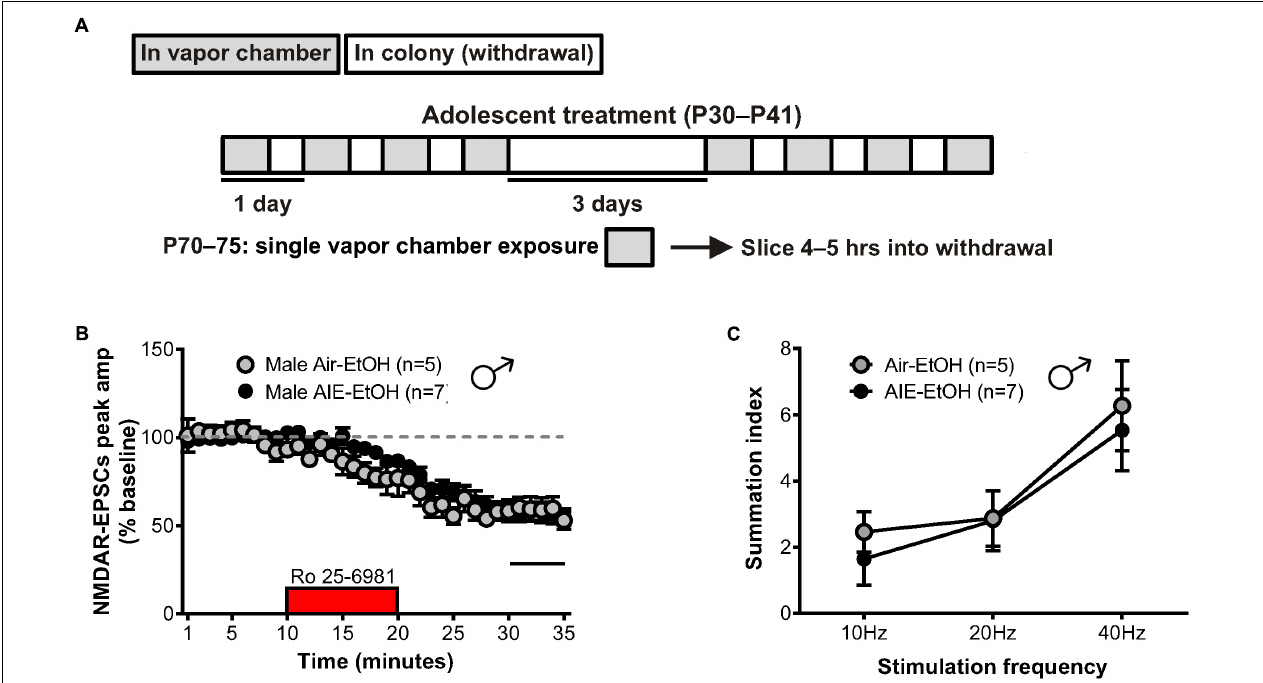
FIGURE 6 | GluN2B transmission and NMDAR metaplasticity in adult male mice with a history of AIE following an ethanol challenge. (A) Protocol used to evaluate whether an ethanol challenge (single 16-h vapor chamber session, EtOH) given during a prolonged period of abstinence would re-engage NMDAR plasticity induced by AIE (AIE-EtOH) relative to air controls (Air-EtOH). (B) Time course of NMDAR-EPSC peak amplitudes following a 10-min application of Ro 25–6981. (C) Plot of the summation index across stimulation frequencies and treatments demonstrating that an alcohol re-exposure had no effect on the temporal summation of NMDA-EPSCs in adult males with a history of AIE. All data points indicate mean ±